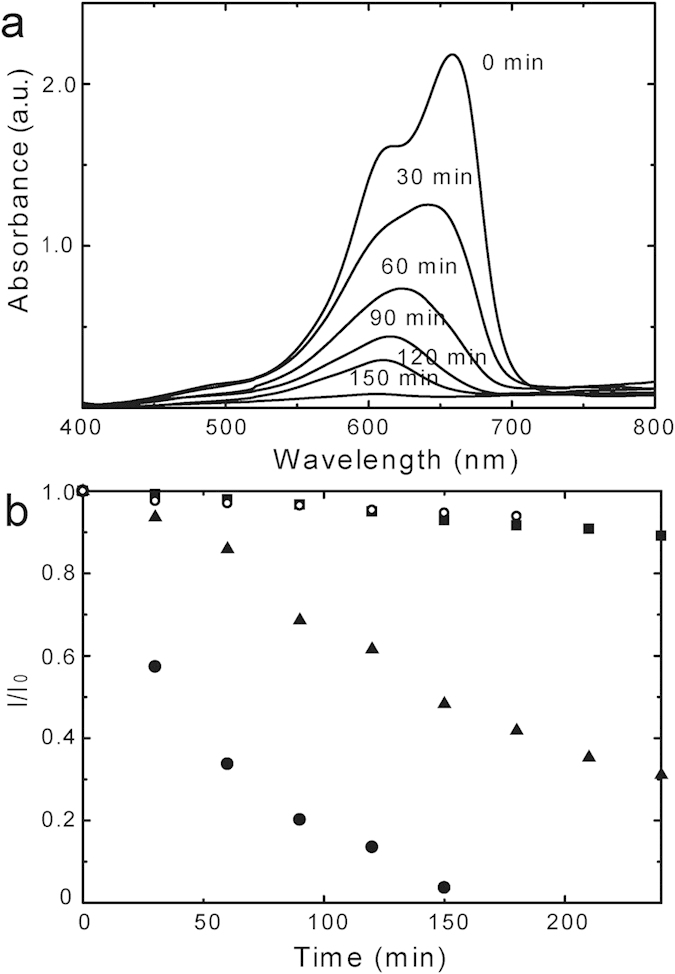
Photocatalytic activity of N-doped TiO2.(a) UV-visible spectroscopic changes of methylene blue solution over TiO2-(1), (b) chronological change of adoption intensity upon various photocatalysts under visible-light (>410 nm) irradiation: no catalyst (circle), TiO2-(1) (black dot), TiO2-(2) (black square) and TiO2-sg (black triangle).